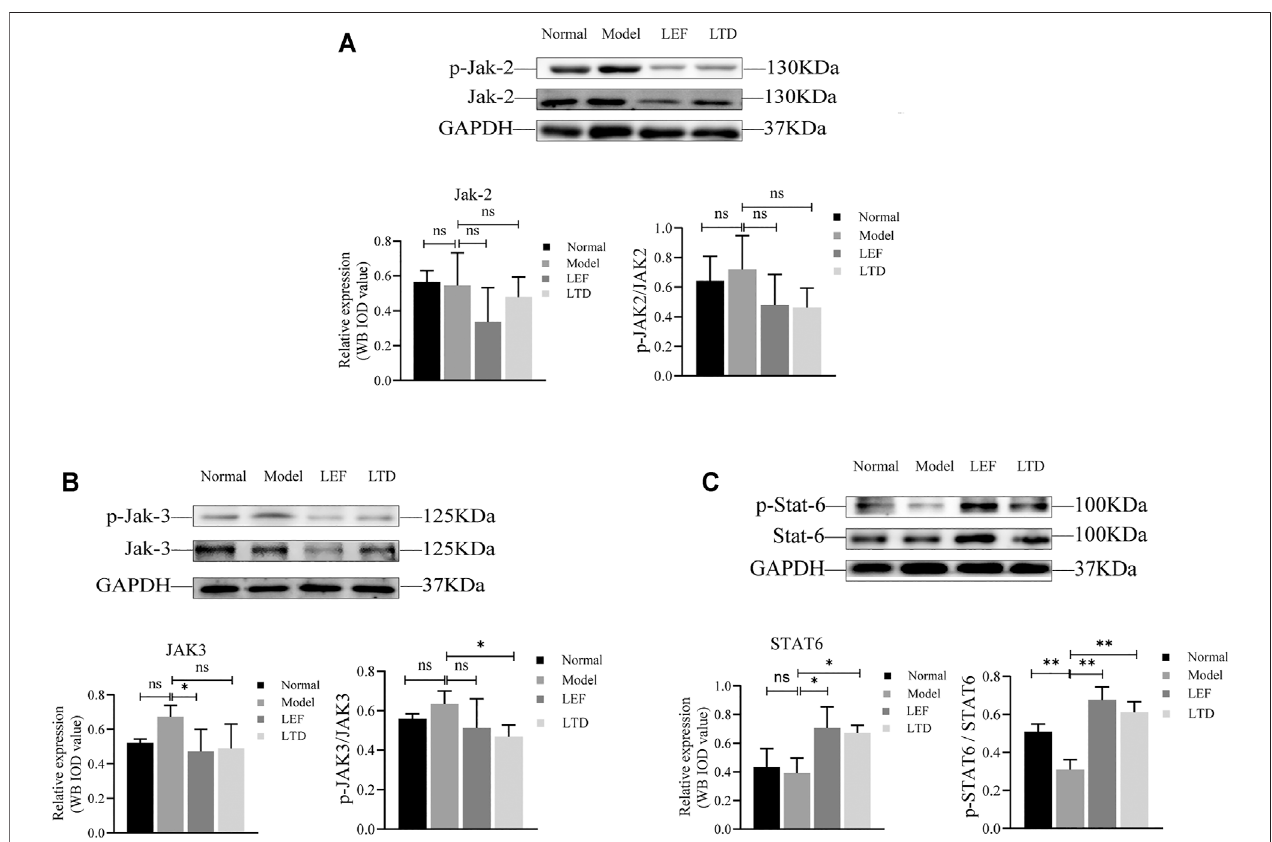
FIGURE 6 | The expression of protein levels. (A) The band diagram of Jak2 protein and its phosphorylation level. (B) The band diagram of Jak3 protein and its phosphorylationlevel. (C) ThebanddiagramofSTAT6 proteinand itsphosphorylationlevel.Thequanti fi edresultsarepresentedinabar chart( n (cid:1) 3).GAPDHwasused as an internal control. Data are presented as means ± S.D. ns p > 0.05, * p < 0.05, ** p <